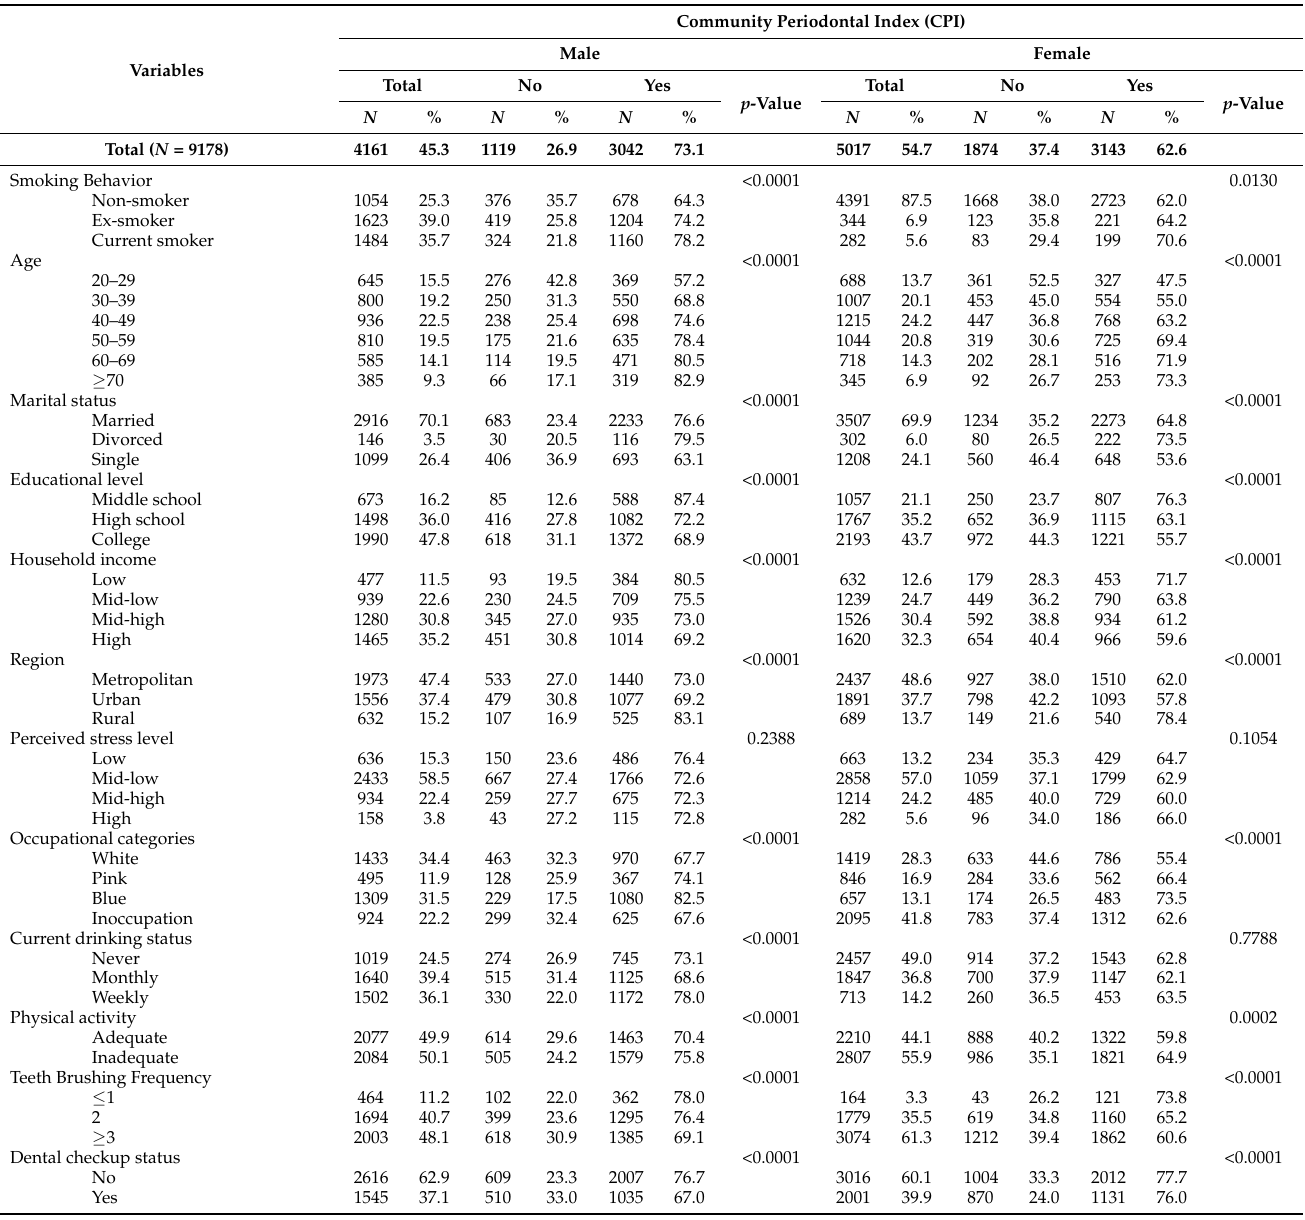
Table 1. General characteristics of the study